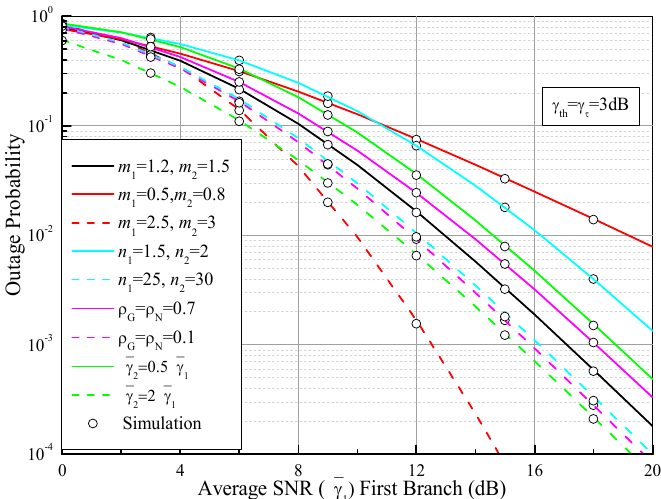
Figure 4. Outage probability values of dual-branch SSC systems as functions of the average SNR ( γ 1 ) first branch over n.i.n.i.d. Fisher–Snedecor F fading channels, where γ th = γ τ = 3 dB.